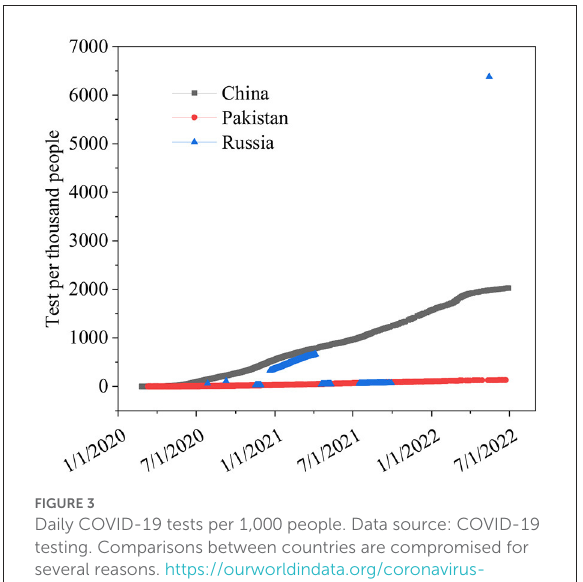
FIGURE3 Daily COVID-19 tests per 1,000 people. Data source: COVID-19 testing. Comparisons between countries are compromised for several reasons. https://ourworldindata.org/coronavirus- testing#source-information-country-by-country, January 7, 2020–June 23,